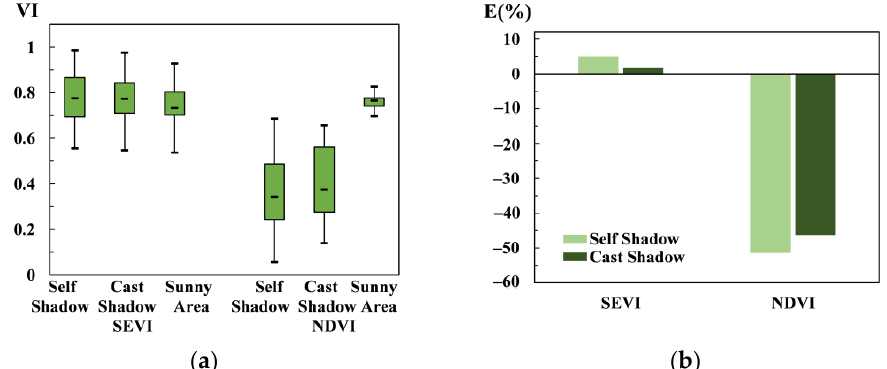
Figure 6. Box plot of samples and histogram of relative error of shadows vs. sunny area: ( a ) Box plot; ( b ) histogram.